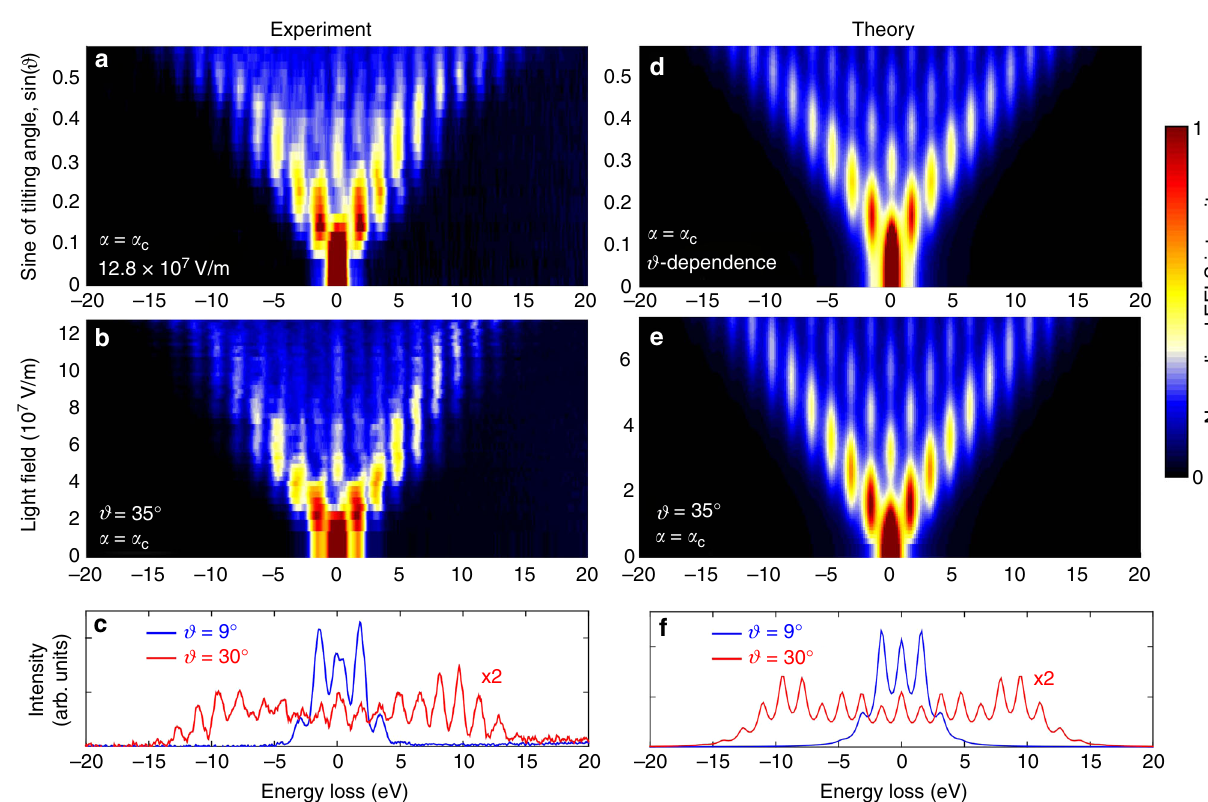
Fig. 2 Energy exchange during electron – light interaction. a Sequence of measured EELS spectra (color map) plotted as a function of increasing angle ϑ . We use p-polarized light (incident fi eld along x axis), α = α C , a peak fi eld amplitude of 12.8 × 10 7 V/m, and light and electron pulse durations τ L = 430 fs and τ = 410 fs. Sidebands at energies ± ‘ (cid:1) h ω relative to the zero-loss peak (ZLP) are visible, where ‘ is the net number of exchanged photons. b Sequence of e EELS spectra measured for increasing light fi eld amplitude with fi xed tilt angle ϑ = 35°. c Spectra selected from a , measured at ϑ = 9° (blue curve) and ϑ = 30° (red curve), showing a strong redistribution of the electron density toward the high-energy sidebands for large tilt angle. d – f Simulated EELS spectra corresponding to the experimental conditions of a – c (see Methods for details of